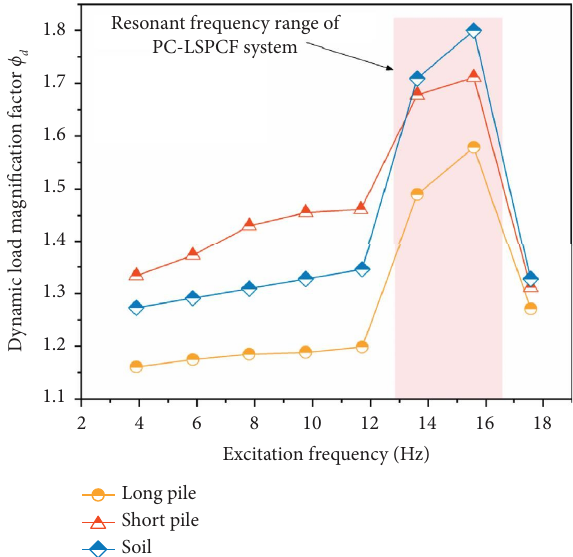
Figure 11: Relationships between the dynamic load magnifcation factor and the excitation